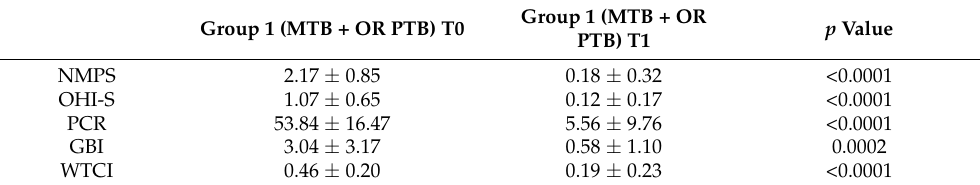
Table 3. Comparison between oral hygiene status in Group 1 after using the rotating and oscillating powered toothbrush for three months (from T0 to T1).